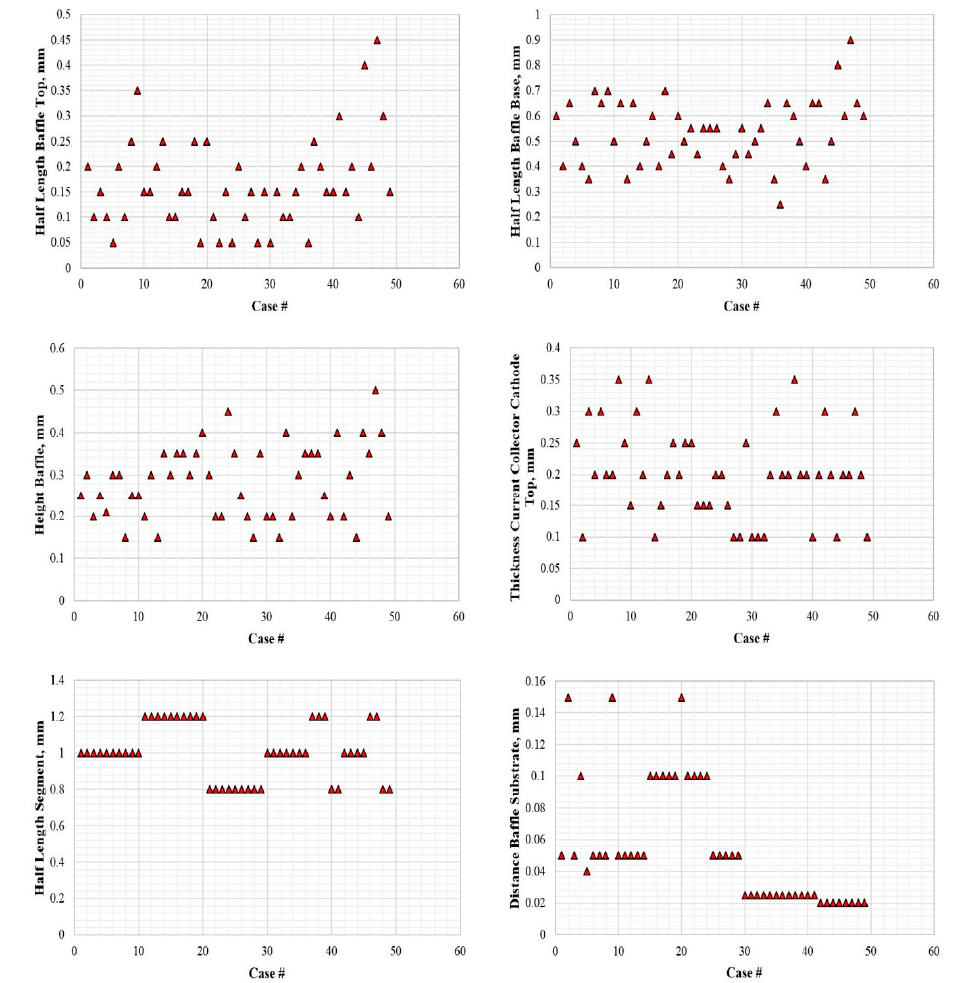
Figure 13. Operating parameters of interest at current density of 4.0 A · cm − 2 for each case.